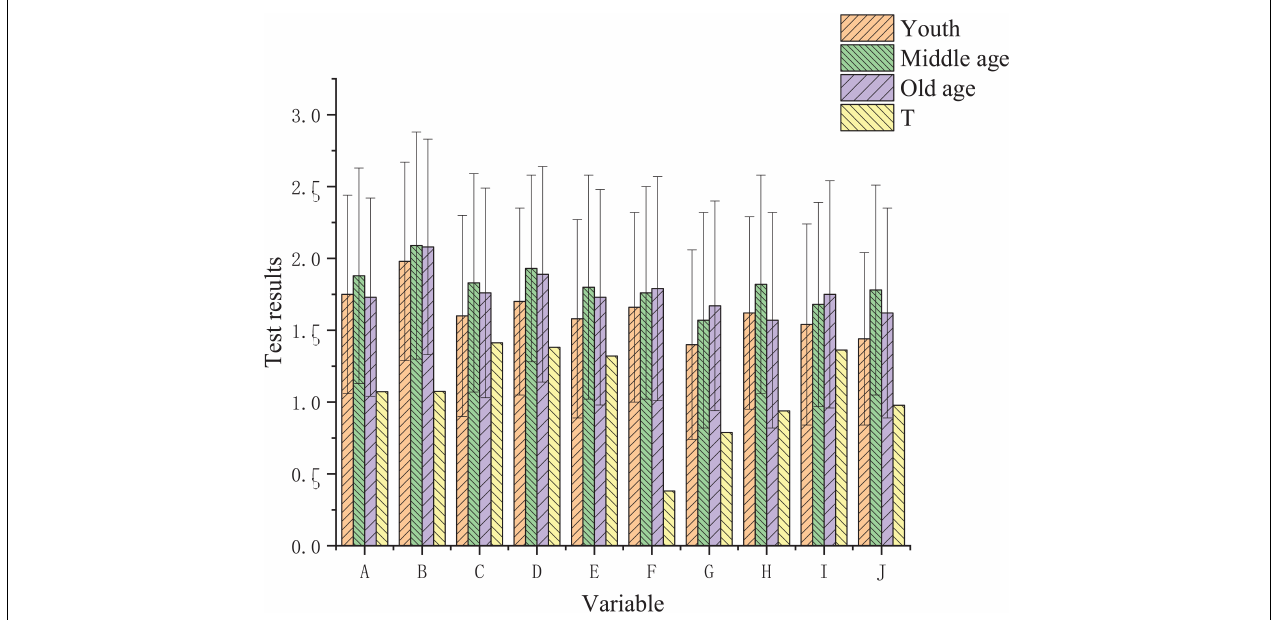
FIGURE 3 | Comparison of survey results of teachers in different age